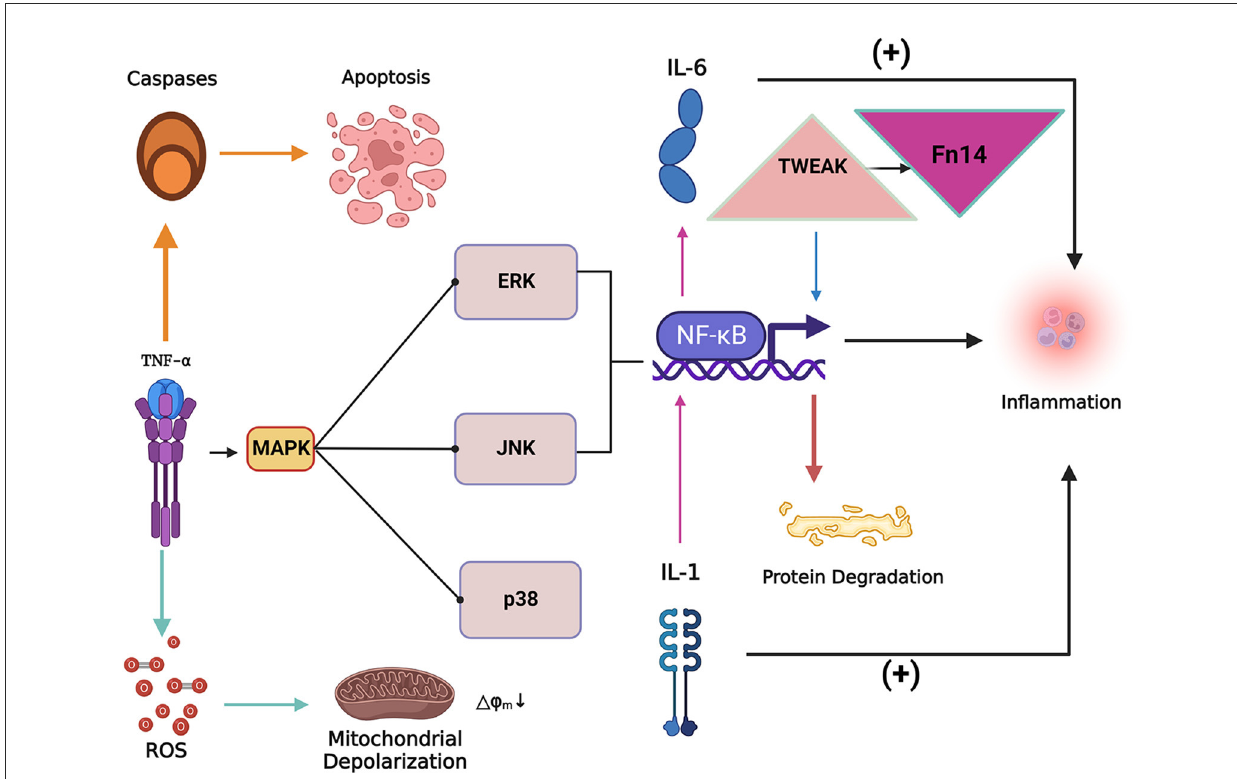
FIGURE3 The inflammatory factor tumor necrosis factor-alpha (TNF- α ) can induce the apoptosis of skeletal muscle cells and lead to the accumulation of reactive oxygen species (ROS). The collection of ROS can lead to mitochondrial dysfunction and depolarization, while TNF- α can activate the MAPK signaling pathway and cause nuclear factor kappa-light-chain-enhancer of activated B cells (NF- κ B). NF- κ B expression levels to increase, inducing inflammation and protein degradation. Tumor necrosis factor-related weak apoptosis-inducing factor (TWEAK) can activate NF- κ B signaling to promote proteolysis and simultaneously increase the expression level of fibroblast growth factor-inducing factor 14 (Fn14), both of which act synergistically in the process of skeletal muscle atrophy. IL-1 (Interleukin 1) and IL-6 (Interleukin 6) are critical inflammatory factors that induce skeletal muscle atrophy. IL-1 stimulates the expression of IL-6 by stimulating the expression of NF- κ B. Overexpression of IL-1 and IL-6 induces an inflammatory response in the body and thus induces skeletal muscle